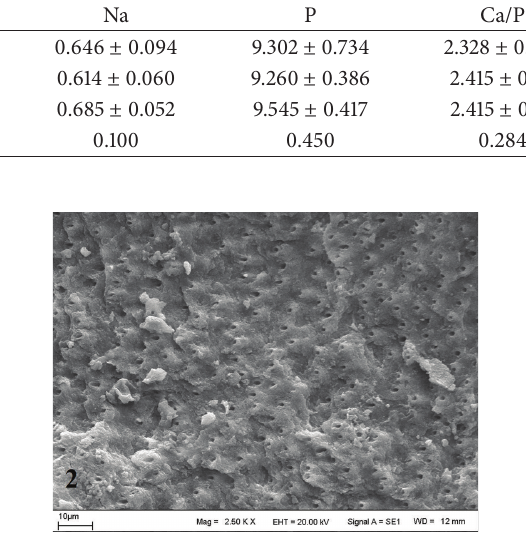
Figure2:SEMmicrographofdentinsurfacetreatedwith3.5 Wlaser in Group B (original magnification × 2.50 k).